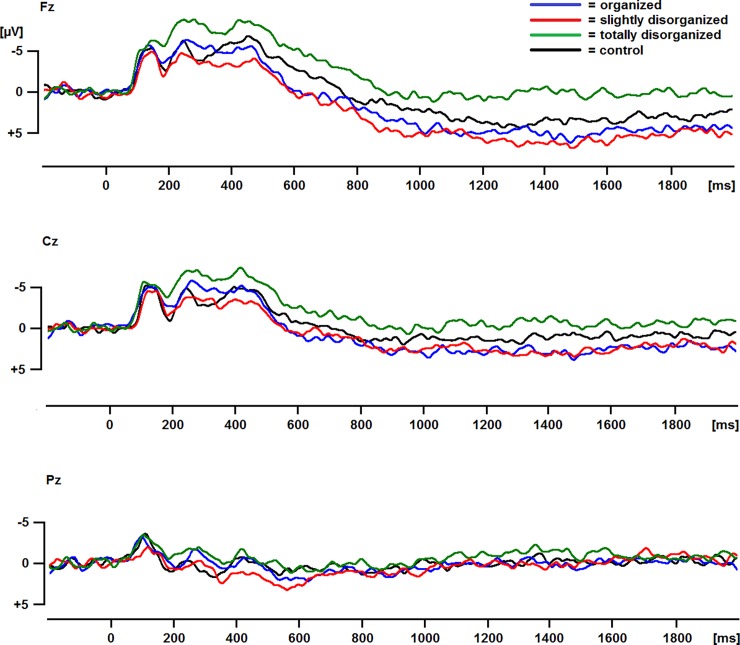
ERPs for each of the four conditions.Positive is plotted downwards.